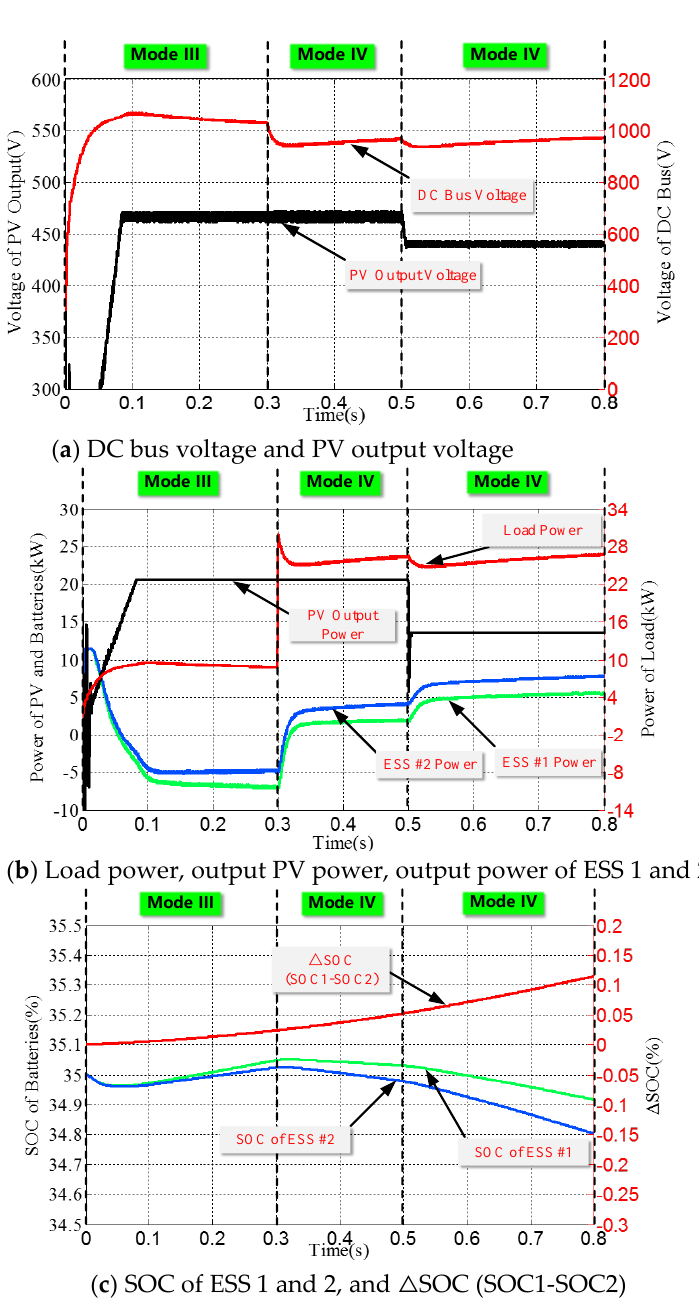
Figure 12. Results of PV-ESS DC microgrid simulation for condition 2.